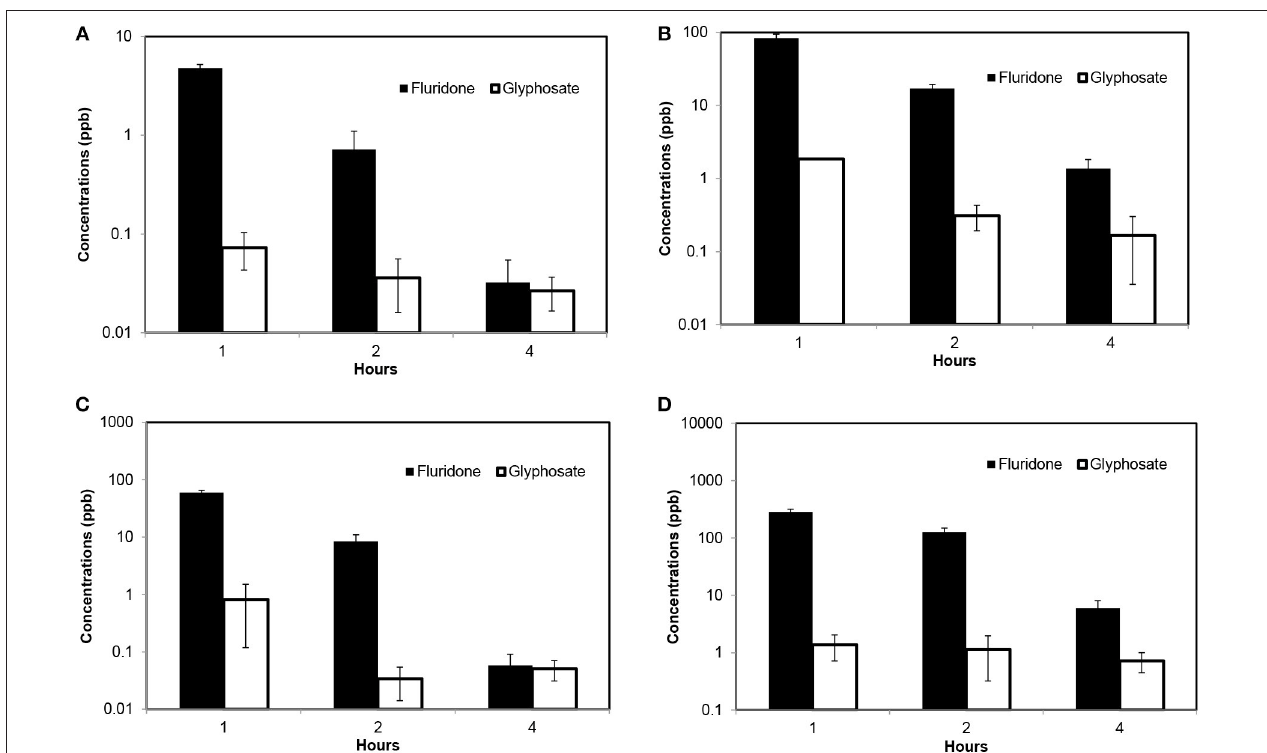
FIGURE 4 | Determination of sediment attached Fluridone and Glyphosate concentrations in leachate after consecutive washes [error bars indicate standard deviation of 3 replicates]. (A) Determination of Fluridone and Glyphosate at initial concentrations of 100 ppb; (B) Determination of Fluridone and Glyphosate at initial concentrations of 1,000 ppb; (C) Determination of Fluridone and Glyphosate at initial concentrations of 500 ppb; and (D) Determination of Fluridone and Glyphosate at initial concentrations of 5,000